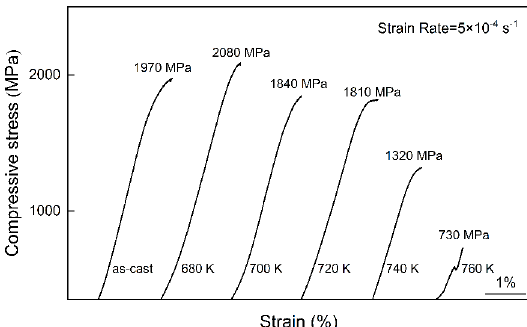
Figure 7. Uniaxial compression stress-strain curves of the samples annealed at different temperatures.